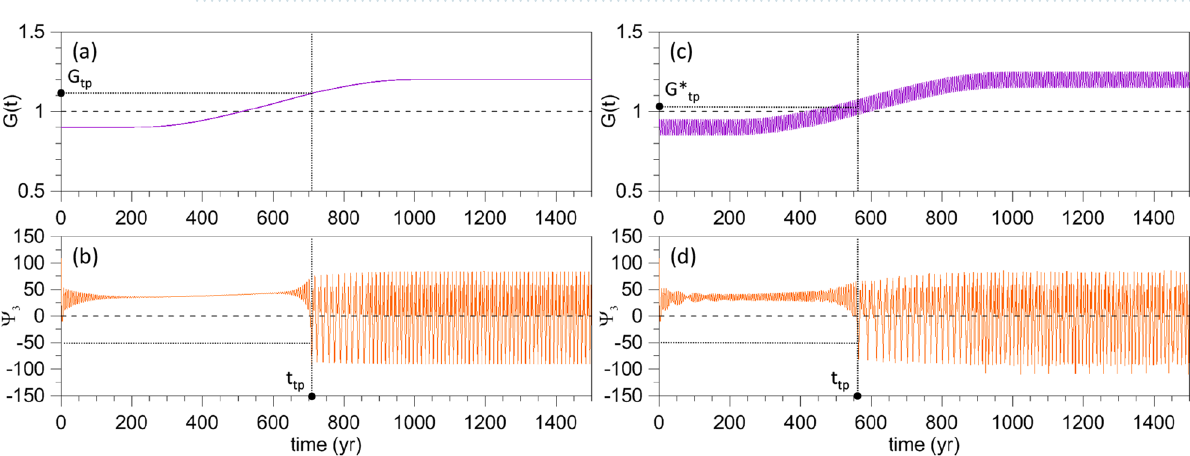
Figure 2. Typical solutions in the two regimes of the model’s autonomous version, cf. Eq. (1), with α = β = 0 in the forcing given by Eq. (2). The constant values γ of the factor G ( t ) in the forcing are shown in the upper panels by a solid purple line, with ( a ) γ = 0.9 and ( c ) γ = 1.2 . The corresponding model solutions are plotted for � 3 ( t ) in the lower panels ( b ) and ( d ); see text and Fig. 4 for the initialization of the trajectories in the lower panels.